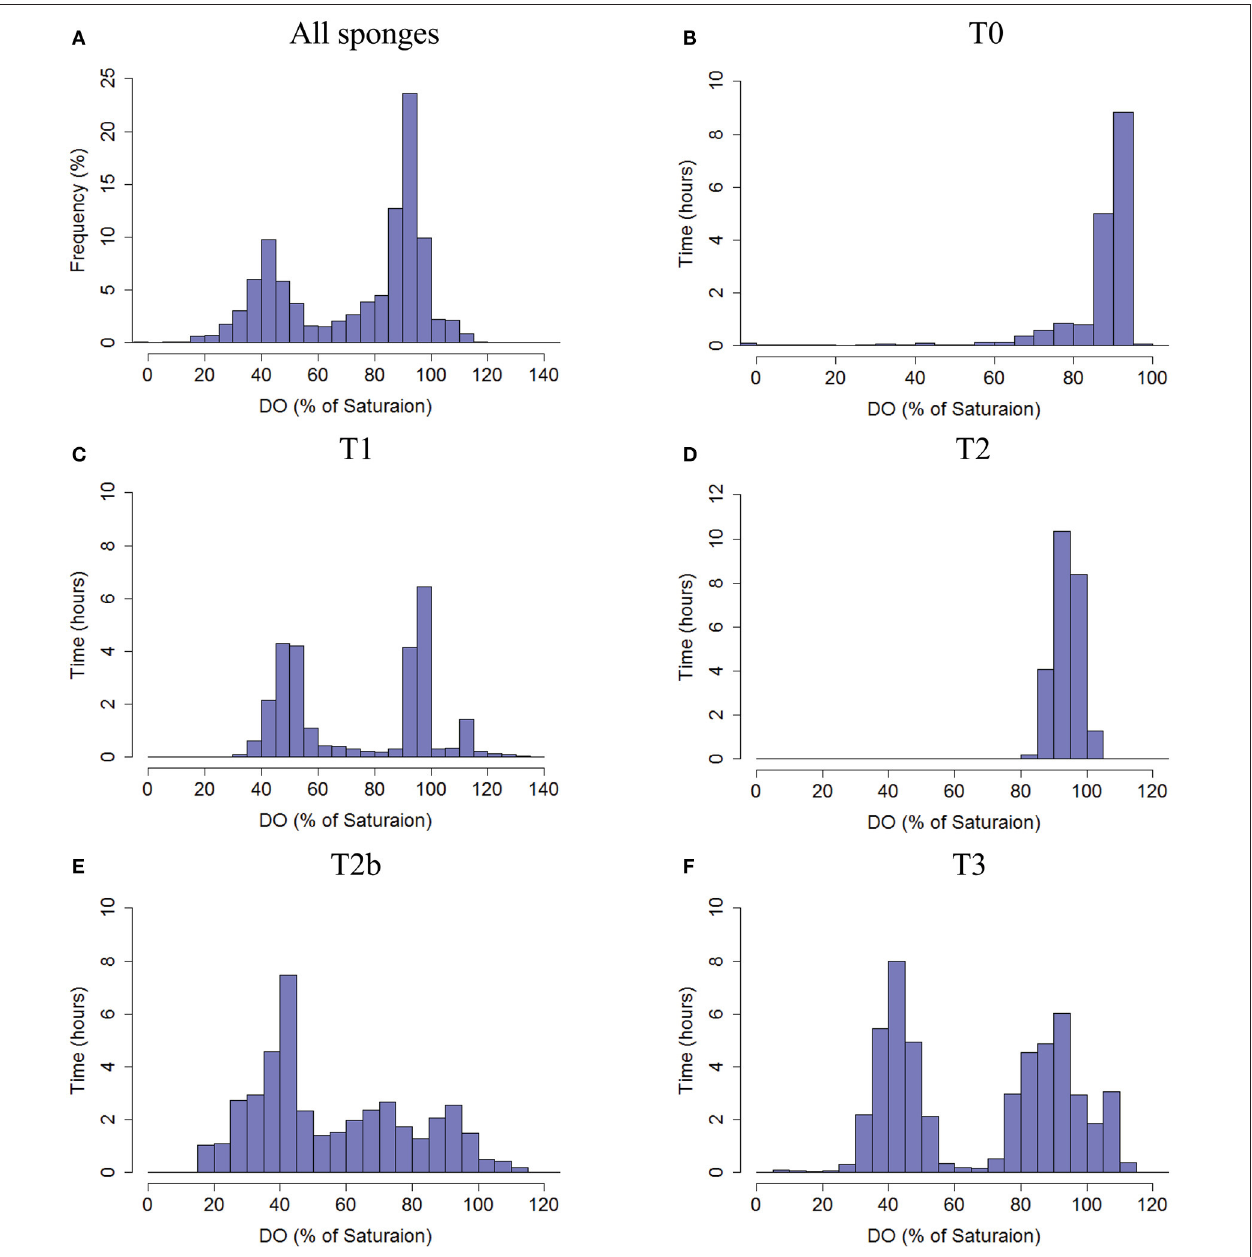
FIGURE 3 | Frequency distribution of the DO saturation (%, 30s averages) in the water exhaled by the sponges as measured in the sponge oscula. (A) The total frequency of DO % of saturation from all sponges pooled together. (B) T0, (C) T1, (D) T2, (E) T2b, and (F) T3. Co-occurrence of DO saturation in osculum and tissue of each sponge is given in Figure